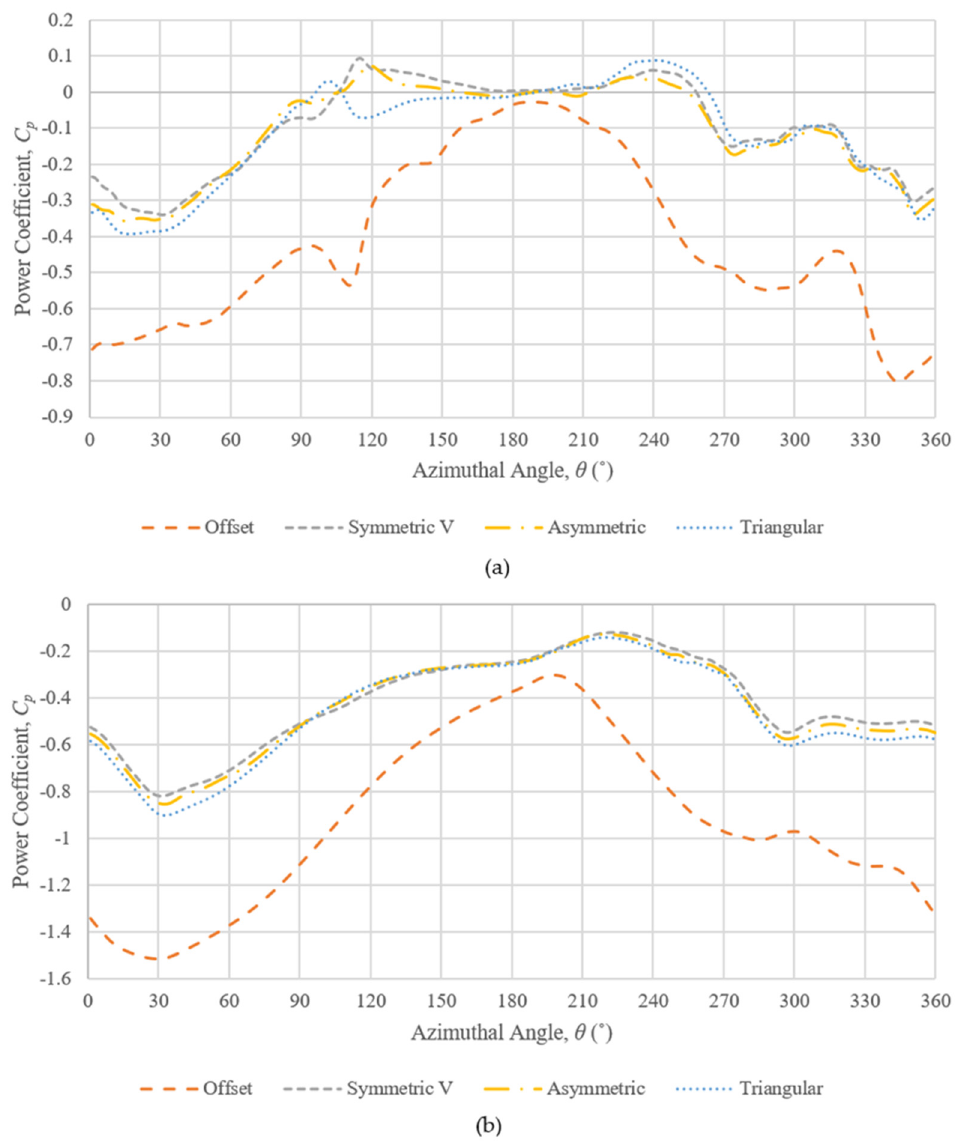
Figure 17. C P on the endplate surface vs. azimuthal angle at ( a ) TSR 1 and ( b ) TSR 2.